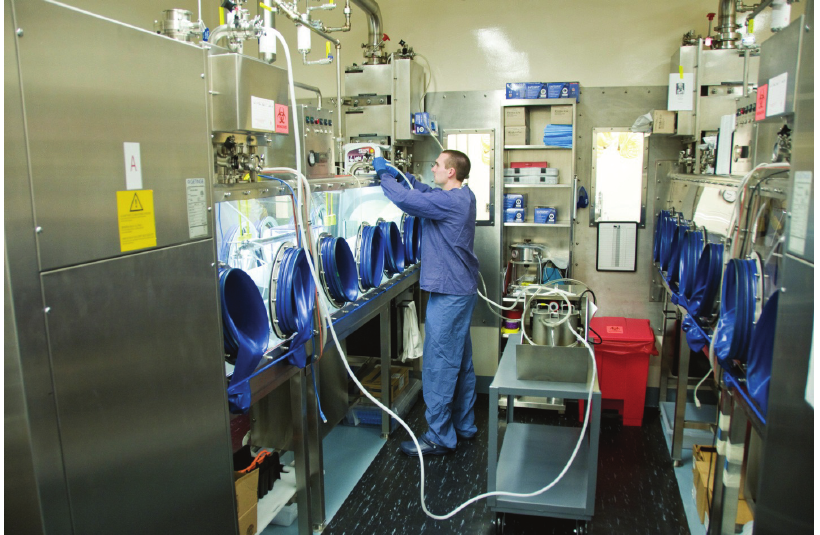
Figure 3. Class III BSC paraformaldehyde gas decontamination setup. After an experiment, a researcher connects a decontamination machine to the BSC through designated external ports on top of the glove box. From a paraformaldehyde gas generator (Certek, Durham, NC, USA), the gas is pumped into the BSC and decontaminates the BSC after an appropriate contact time ( i.e. , 6 h). The gas is then neutralized by ammonium bicarbonate for an additional 6 h (12 h total decontamination). Biological indicators are placed throughout the BSC and the results are recorded and analyzed by